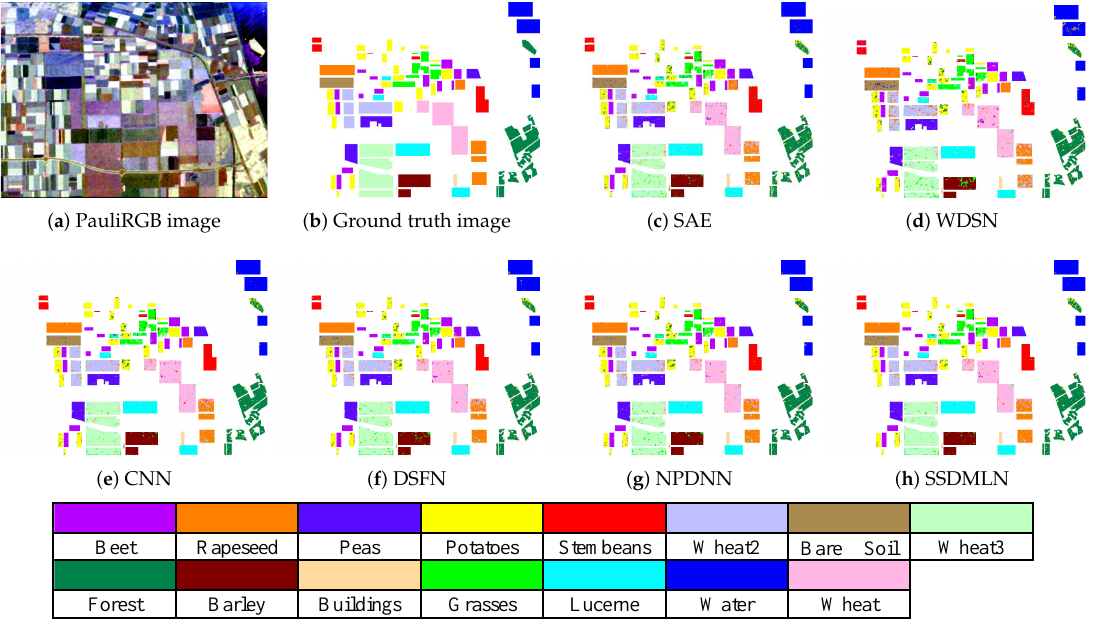
Figure 5. Comparison of classification results on the Flevoland data set using 1% labeled data. ( a ) PauliRGB image. ( b ) Ground truth image. ( c ) SAE [8]. ( d ) WDSN [9]. ( e ) CNN [10]. ( f ) DSFN [16]. ( g ) NPDNN [17]. ( h ) SSDMLN (ours). Table 2. Classification results (%) on the Flevoland data set with 1% labeled data.